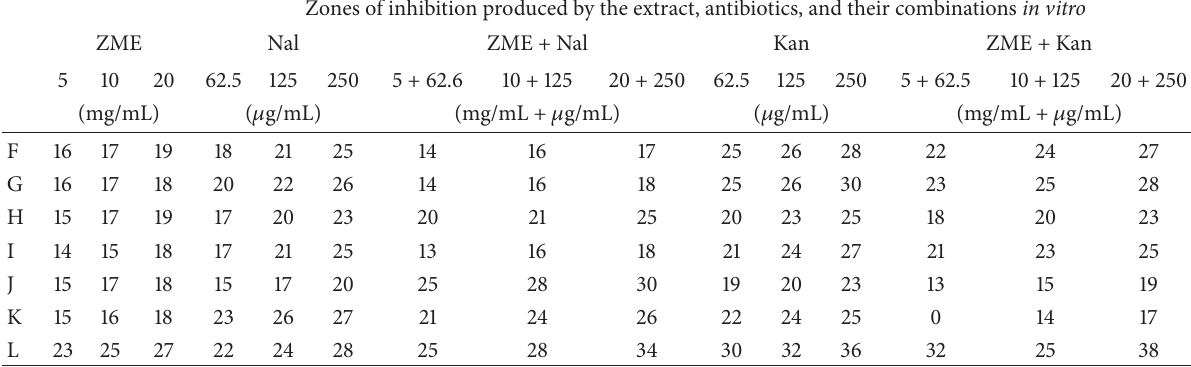
Key: A: E. coli ATCC 8739; B: B. cereus ATCC 10702; C: B. subtilis KZN; D: P. aeruginosa ATCC 19582; E: S. marcescens ATCC 9986; F: A. calcoaceticus anitratus UP; G: K. pneumoniae ATCC 10031; H: P. vulgaris ATCC 6830; I: E. faecalis ATCC 29212; J: S. aureus OK 2a ; K: S. aureus OK 2b ; L: S. flexneri